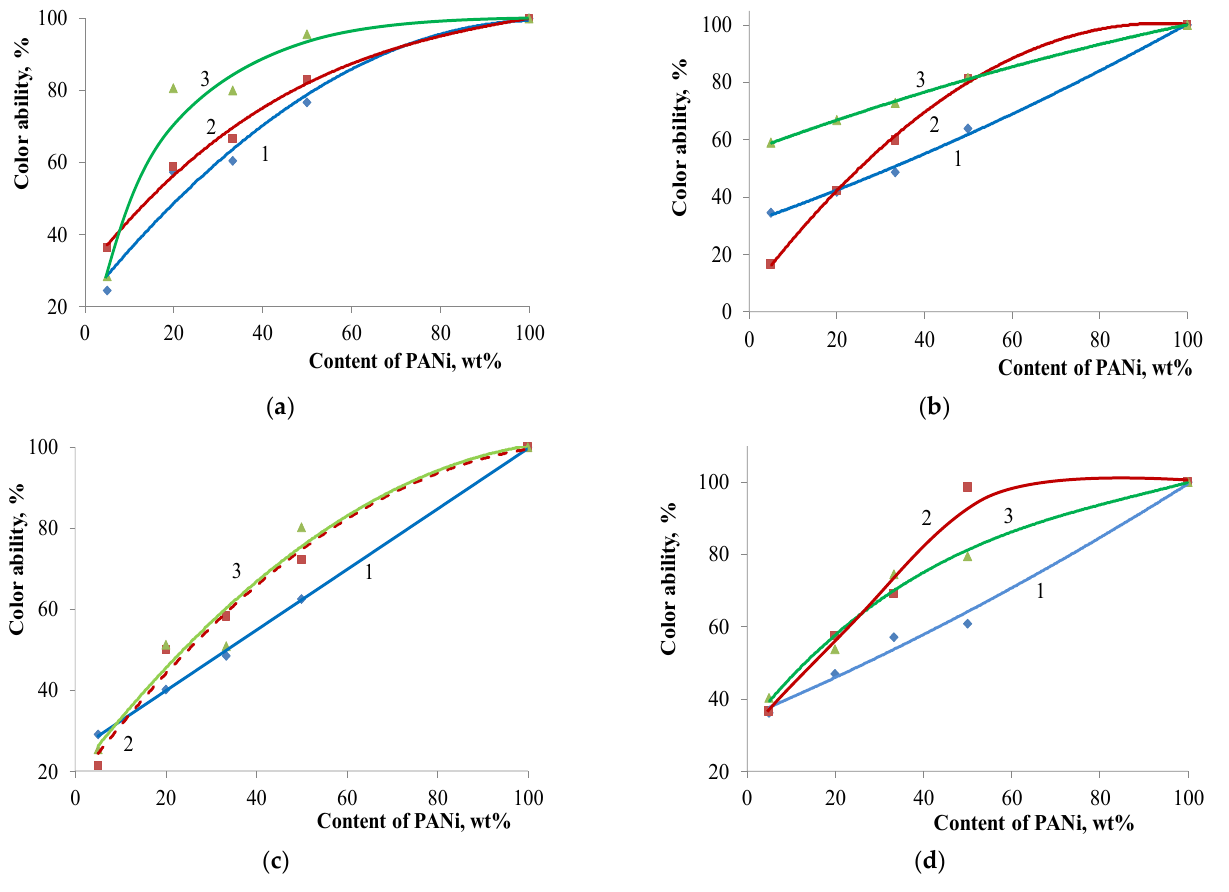
Figure 10. Coloring strength of core pigments with a various base vs. the content of PANi doped with various acids: ( a ) kaolin-based core/shell pigment; ( b ) bentonite-based core/shell pigment; ( c ) talc-based core/shell pigment; ( d ) muscovite-based core/shell pigment. Doping acid: (1) H 2 SO 4 ; (2) HCl; (3) H 3 PO 4